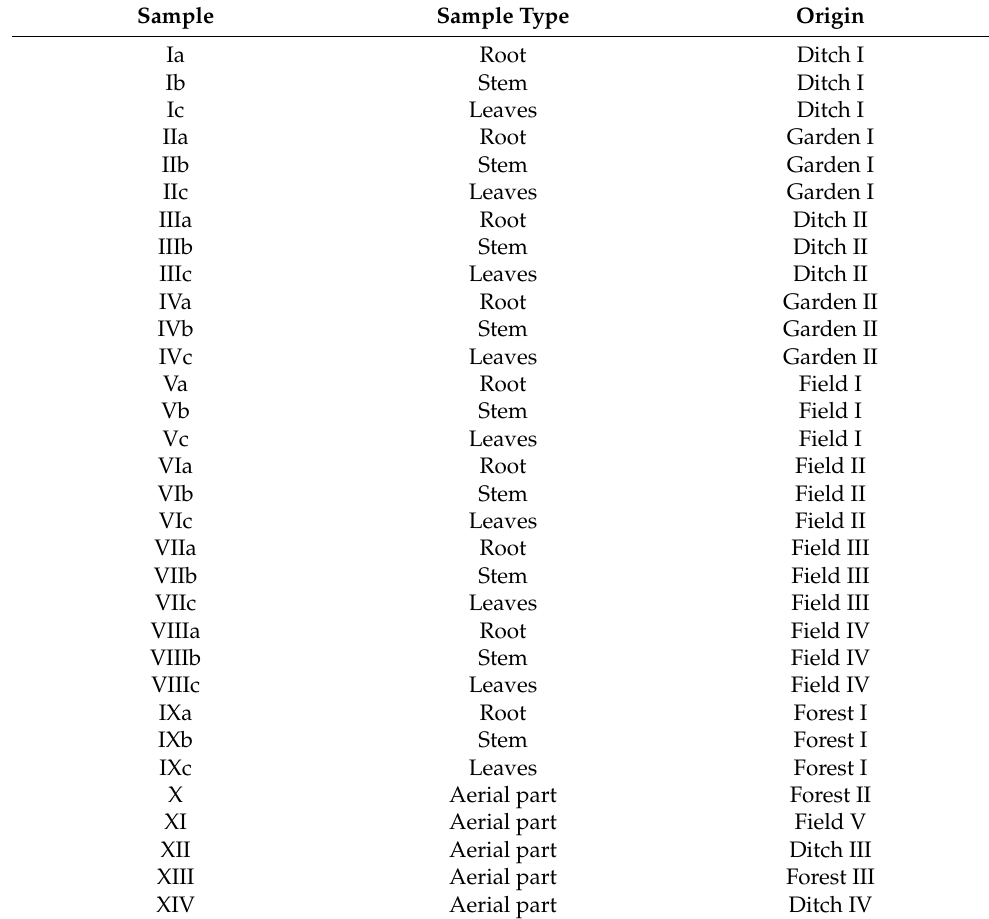
Table 6. Sample type and sampling location in the vicinity of Pozna´n, Great Poland region